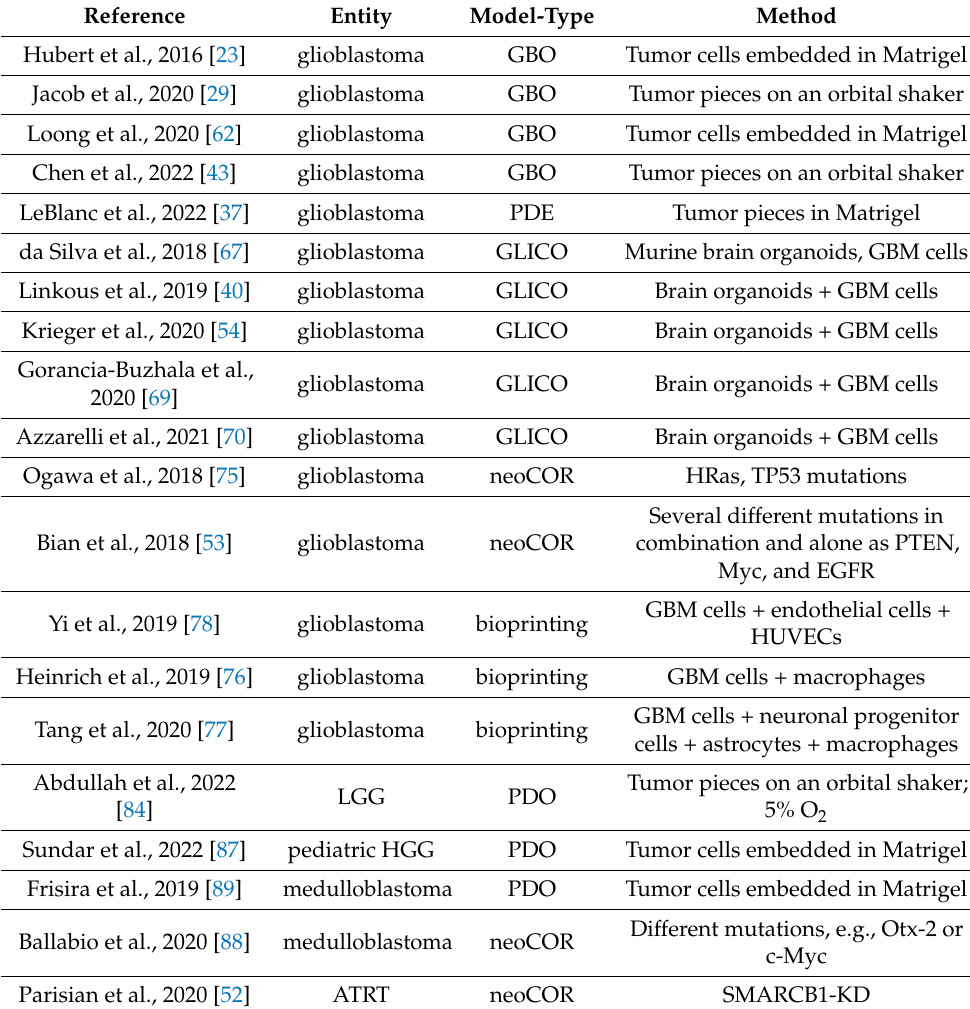
Table 1. Established three-dimensional brain tumor